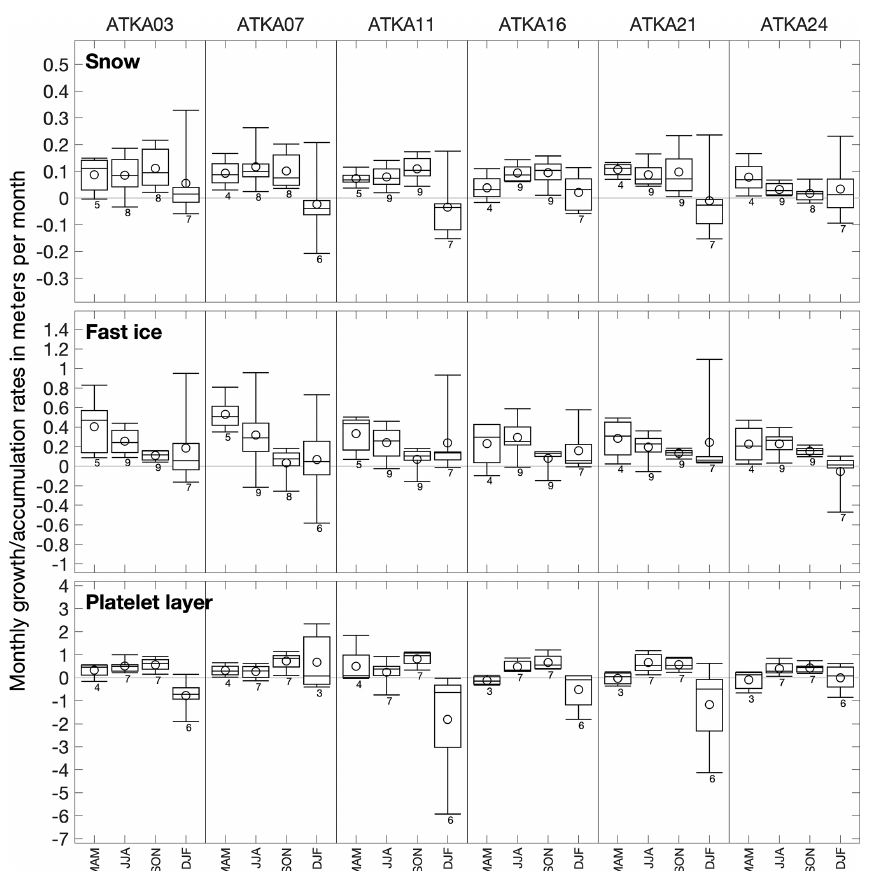
Figure 6. Seasonal snow, sea-ice, and platelet-layer accumulation/growth and melt rates separated for austral fall (March, April, May; MAM), winter (June, July, August; JJA), spring (September, October, November; SON), and summer (December, January, February; DJF) for each ATKA sampling point for the study period from 2010 to 2018. Boxes are the first and third quartiles and whiskers the 20th and 80th percentiles. Circles indicate the mean and horizontal lines in the boxes the median. Numbers below the whiskers indicate the respective sampling size, i.e., the number of included years, with a maximum of